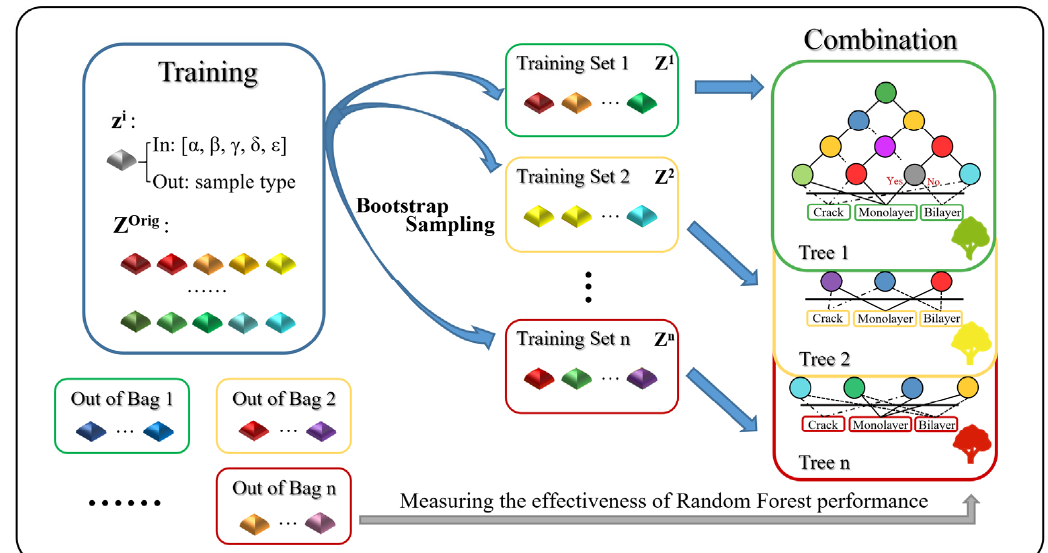
Figure 4. Basic architecture of the learning procedure in the random forest method. Each small square represents a spatial measurement point carrying Raman characteristic information. The subtraining sets from 1 to n are acquired by a bootstrap sampling process, and then decision trees based on these subtraining sets can be built. The out-of-bag data of each tree can be used to estimate the effectiveness of the trained random forest model.